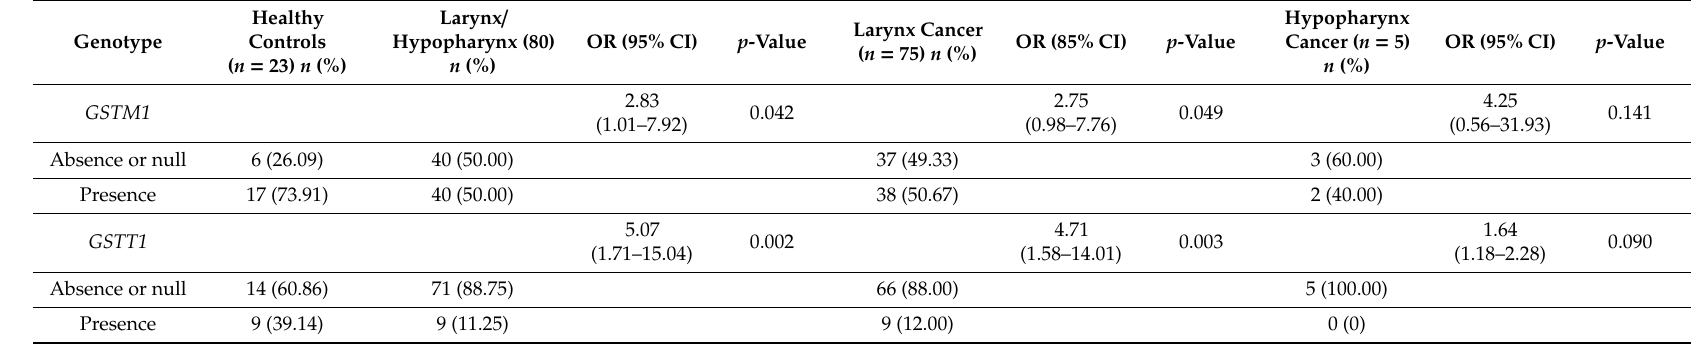
Table 3. Distribution of genotypes of GSTM1 and GSTT1 among healthy controls and patients with larynx or hypopharynx cancer (Pearson χ 2